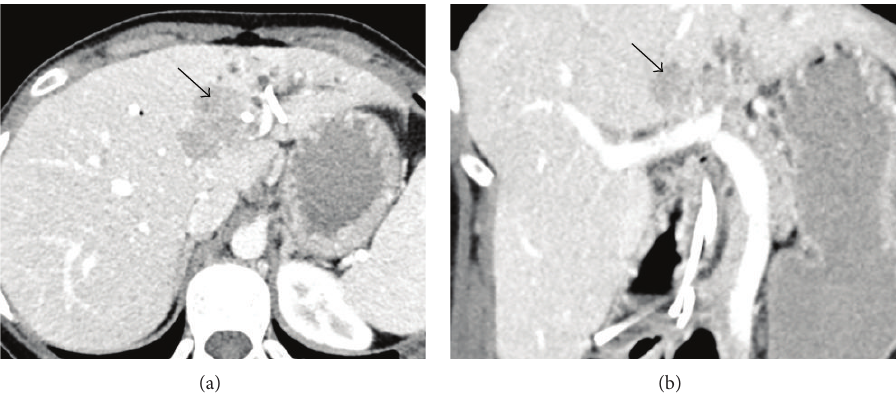
Figure 2: CT of the liver lesion (black arrow) in axial (a) and coronal (b) sections demonstrating an ill-defined heterogeneous soft tissue density in segment 4 as well as extensive intrahepatic biliary duct dilatation in segments 2 and 3 with